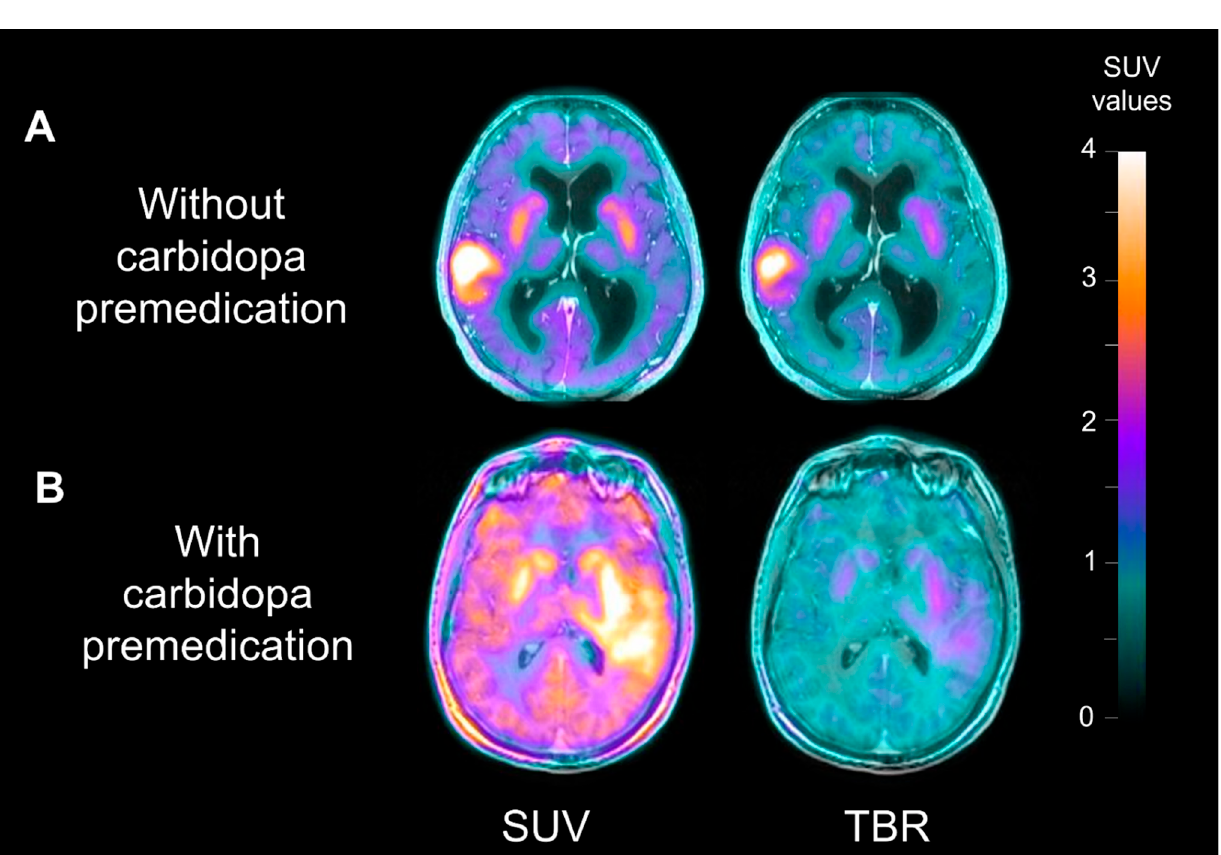
Figure 2. Representative examples of two patients with or without carbidopa premedication, before and after using tumor-to-healthy-brain ratio parametric images. Patient ( A ) is a 66-year-old woman with a newly diagnosed IDH wildtype glioblastoma (SUV mean 3.2). Patient ( B ) is a 32-year-old man with a newly diagnosed IDH wildtype glioblastoma (SUV mean 4.1). The two tumors are clearly different on TBR-parametric images, even though they have essentially the same SUV values on SUV-parametric images. Note the higher SUV uptake of striatal and healthy brain areas on B due to the carbidopa premedication.